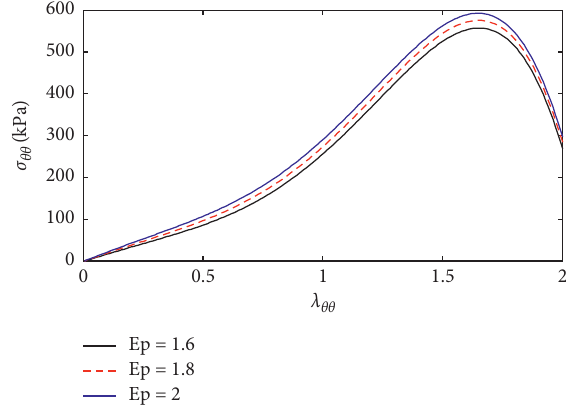
Figure 10: Study of the influence of the elasticity modulus on circumferential stress.